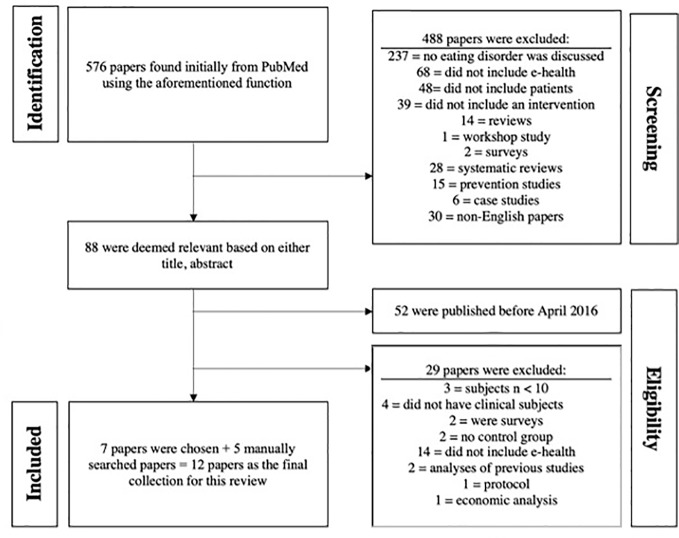
Breakdown of the initial cluster of papers found using the PubMed database.